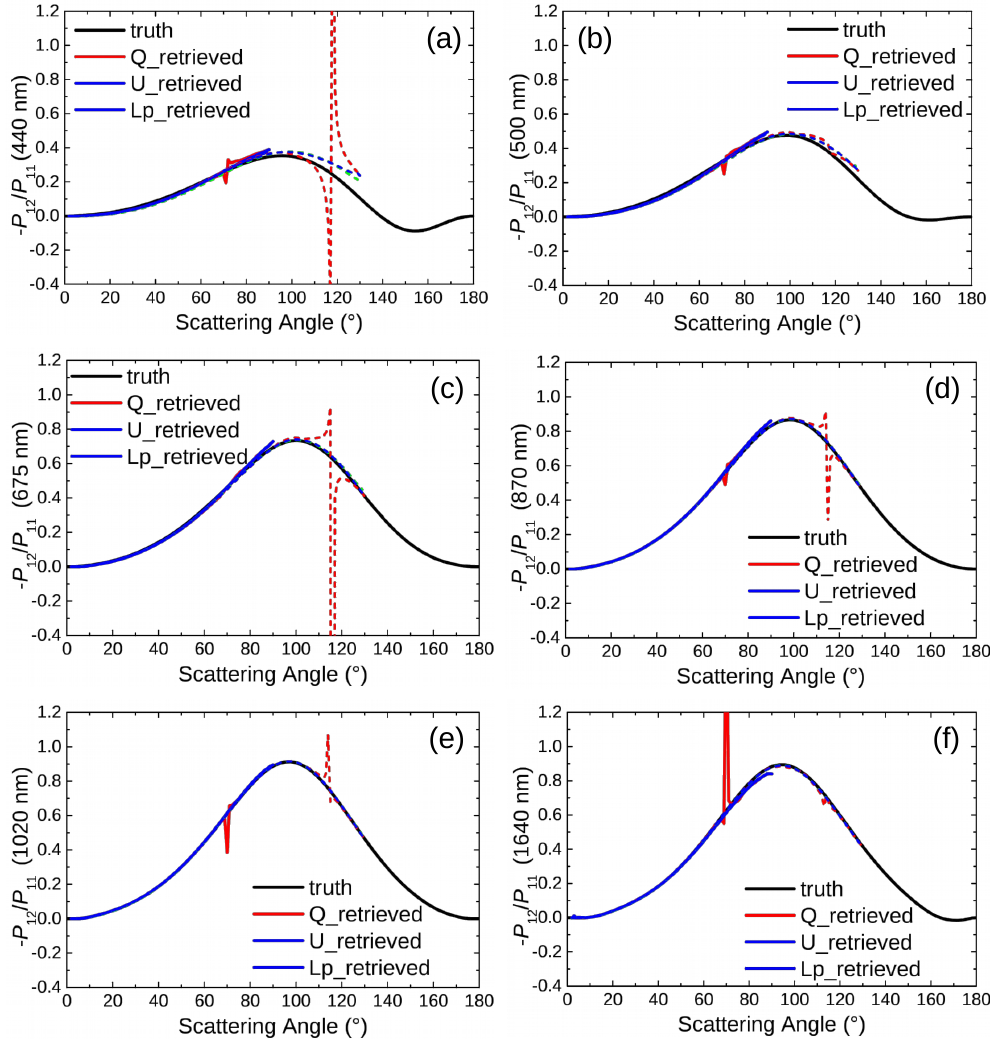
Figure 4. Comparison of - P 12 / P 11 retrieved from the Stokes parameters Q , U and the polarized radiance L p at different solar zenith angles for the almucantar observation geometry. The curve notation is as: solid lines for results with SZA of 45 0 ; dashed lines for results with SZA of 65 0 ; red lines for the results derived from Q ; green lines for the results derived from U ; and blue lines for the results derived from L p